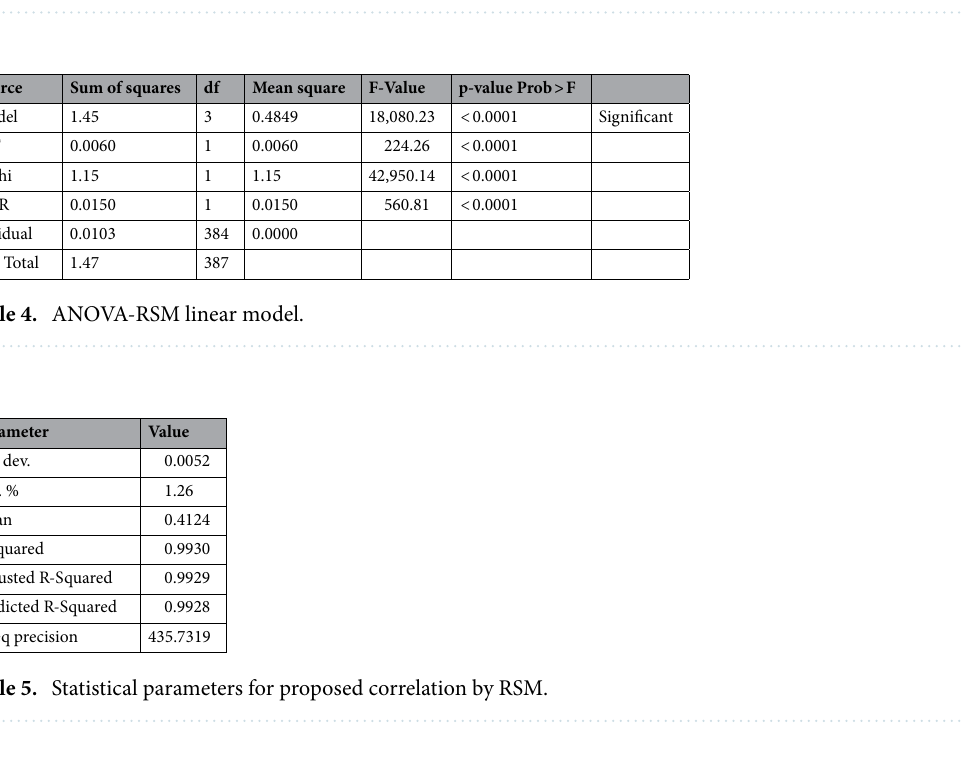
Figure 10. Comparison of our results with the various theoretical models.